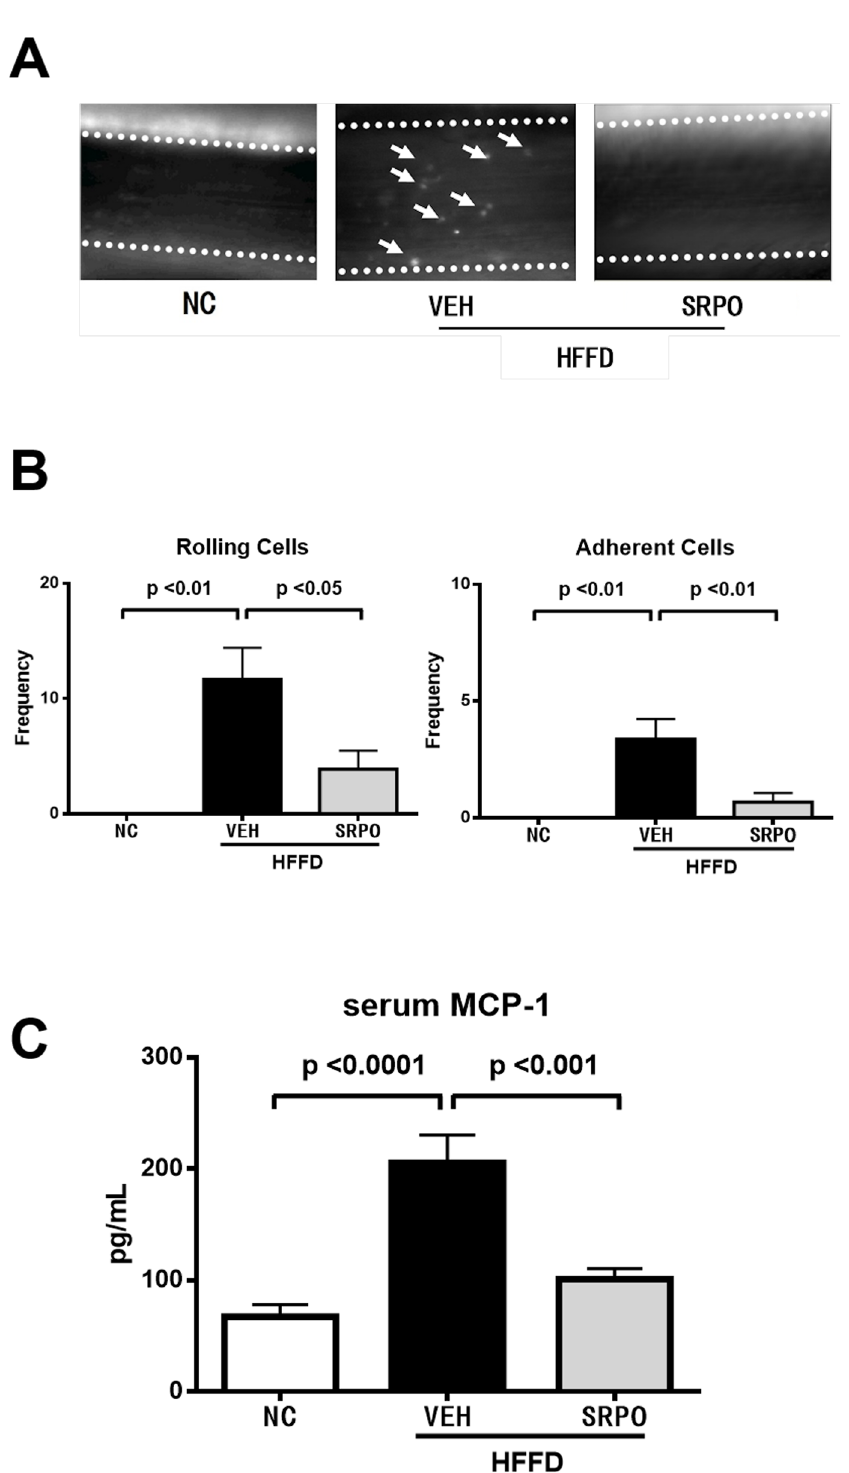
Fig 2. SRPO significantly decreased leukocyte-endothelial interactions and serum MCP-1 level. (A) Image of leukocyte-endothelial interactions in the femoral arteries of mice (with the margins of vessels indicated by dotted lines). Arrows indicate adhered or rolling leukocytes. (B) The numbers of rolling (left) and adherent cells (right) in all groups were calculated as described in Methods. Values are the mean ± SE (n = 10, 16, 18). (C) Effect of SRPO on serum MCP-1 levels in HFFD-induced obesity. Values are